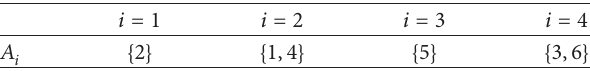
Table 2: Current employees’ tasks.